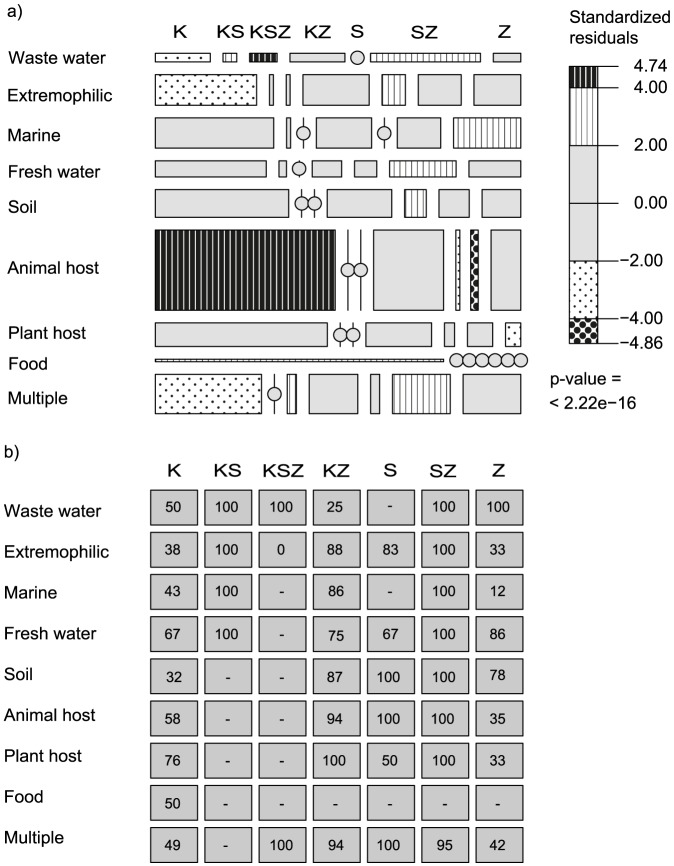
Gene co-occurrence types and habitat preference.a) Mosaic plot of nirK (K), nirS (S) and nosZ (Z) co-occurrence types across different habitat categories where tile size reflects the number of occurrences and patterns indicate significant overrepresentation (>2) or underrepresentation (<−2) of co-occurrence patterns, as determined by standardized Pearson residuals from χ2 test results (P<0.001). Circles indicate non-occurring combinations. b) The percentage of organisms harboring a nor gene for each combination across the habitat categories. No value indicates non-occurring combinations.